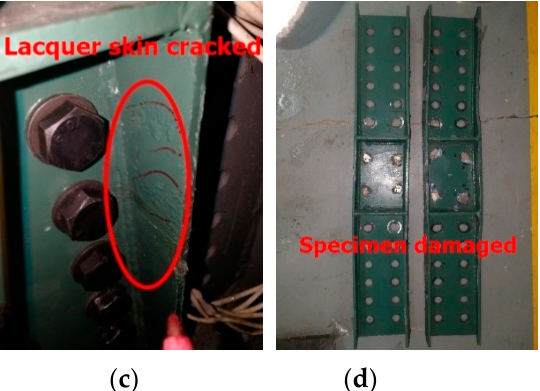
Figure 7. Failure modes of RSL-2. ( a ) flange bending; ( b ) flange cured inward; ( c ) lacquer skin cracked; ( d ) specimen damaged.